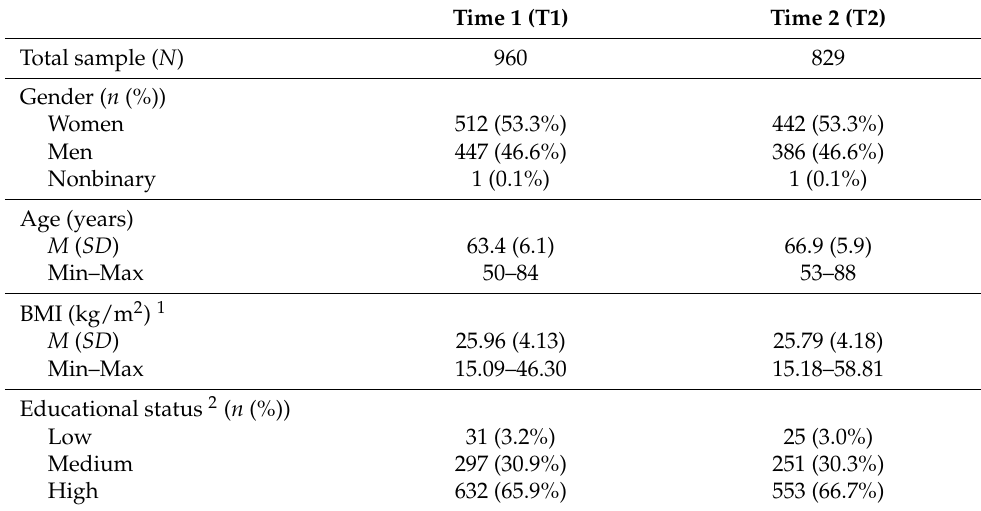
Table 1. Sample characteristics of the NFS at T1 and